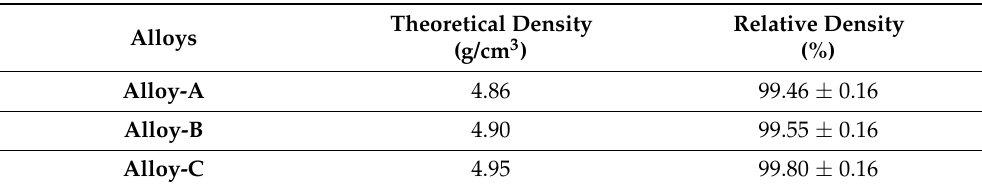
Table 2. Relative destiny of the experimental alloys fabricated by high-pressure spark plasma sintering (HFIHS)